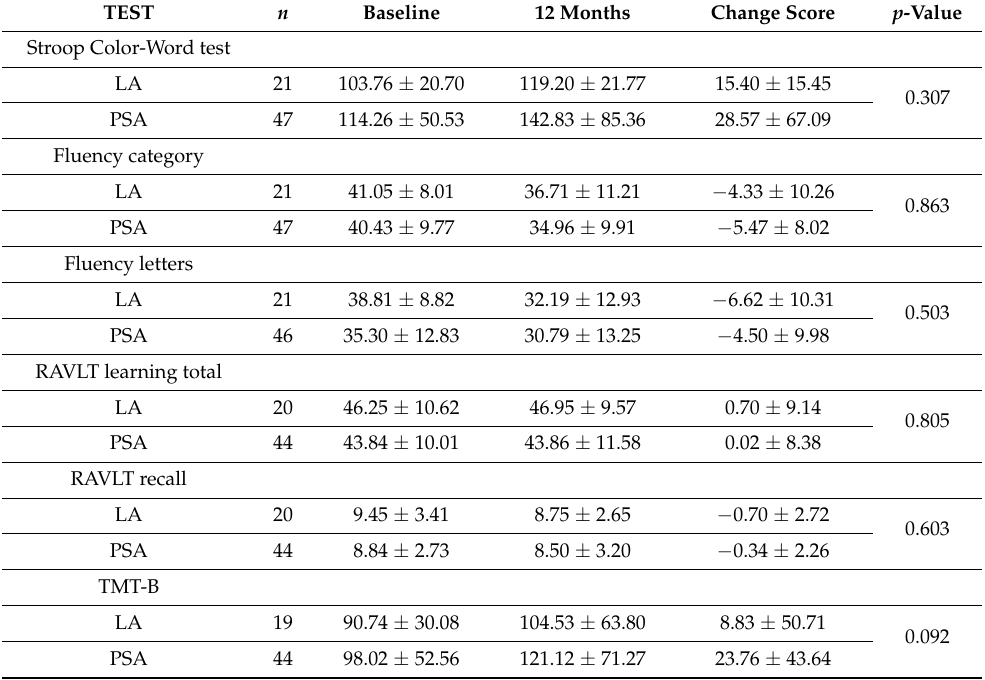
Table 3. Neuropsychological test scores at baseline and after 12